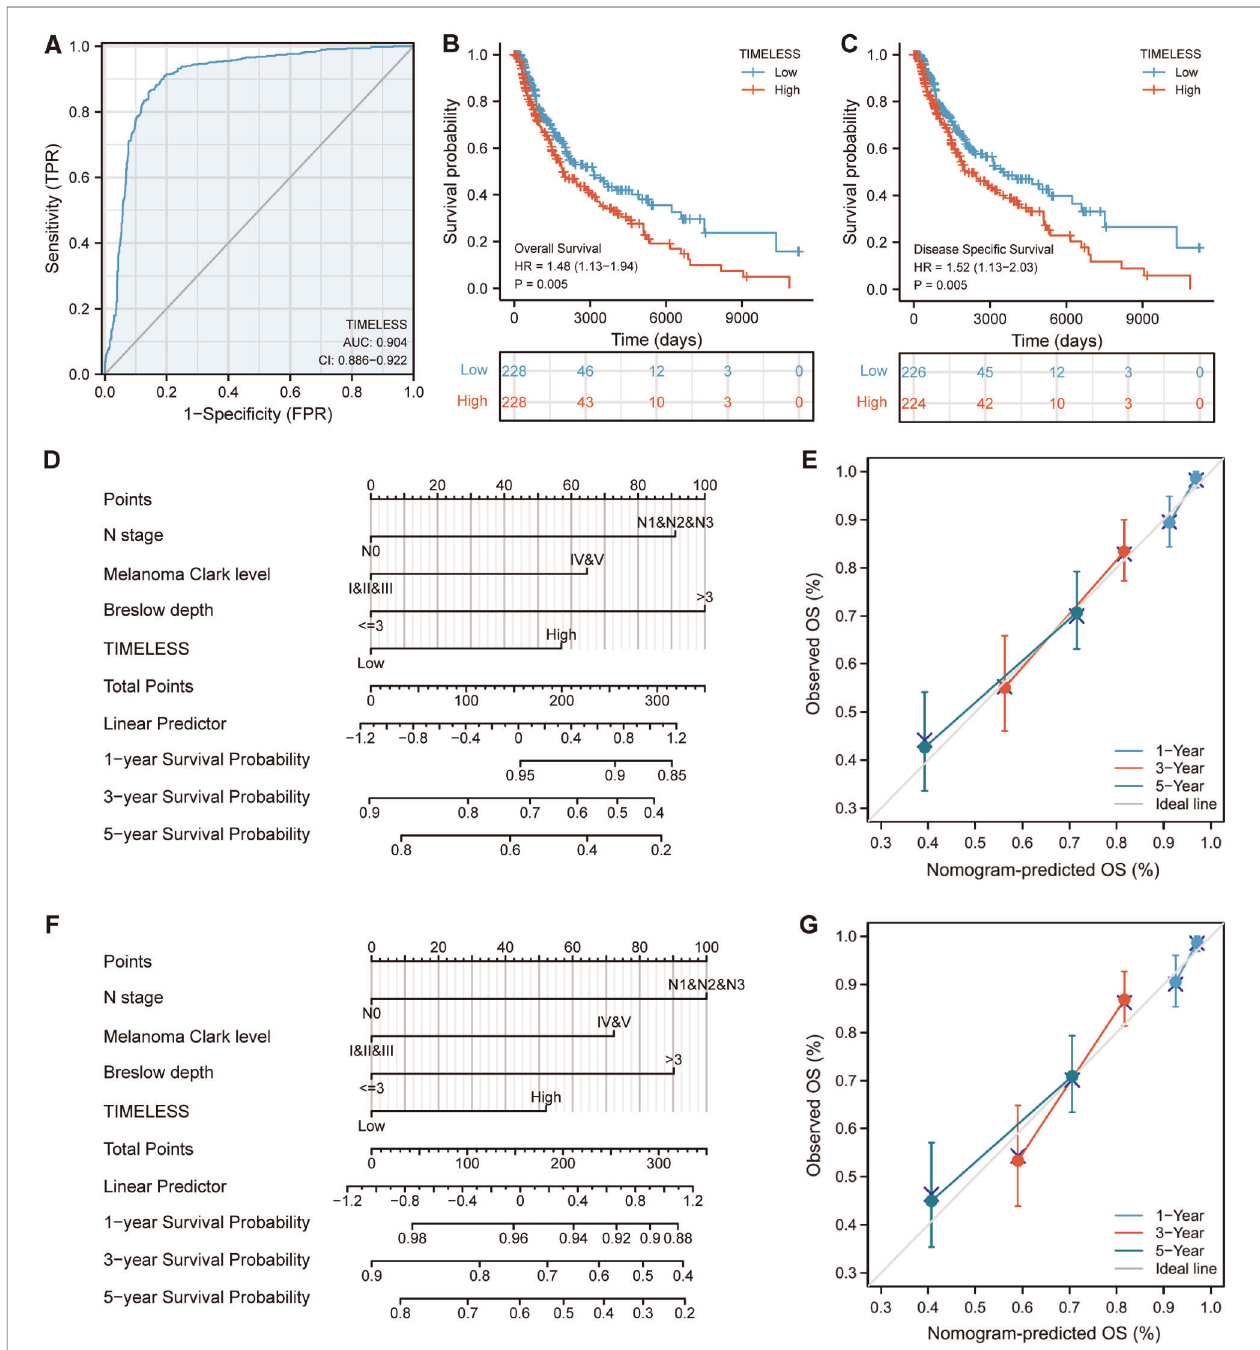
FIGURE 5 | Predictive value of TIM for diagnosis and prognosis in SKCM patients. ( A ) ROC curve analysis evaluating the performance of TIM for SKCM diagnosis. Shown were the K-M analyses comparing OS ( B ), and DSS ( C ) between the two distinct TIM expression subgroups. ( D – G ) Construction and validation of nomograms based on TIM expression. Shown were the nomograms constructed to predict the probability of 1-, 3-, 5-year OS ( D ), and DSS ( F ) for SKCM. Calibration plots of OS, and DSS were shown in ( E,G